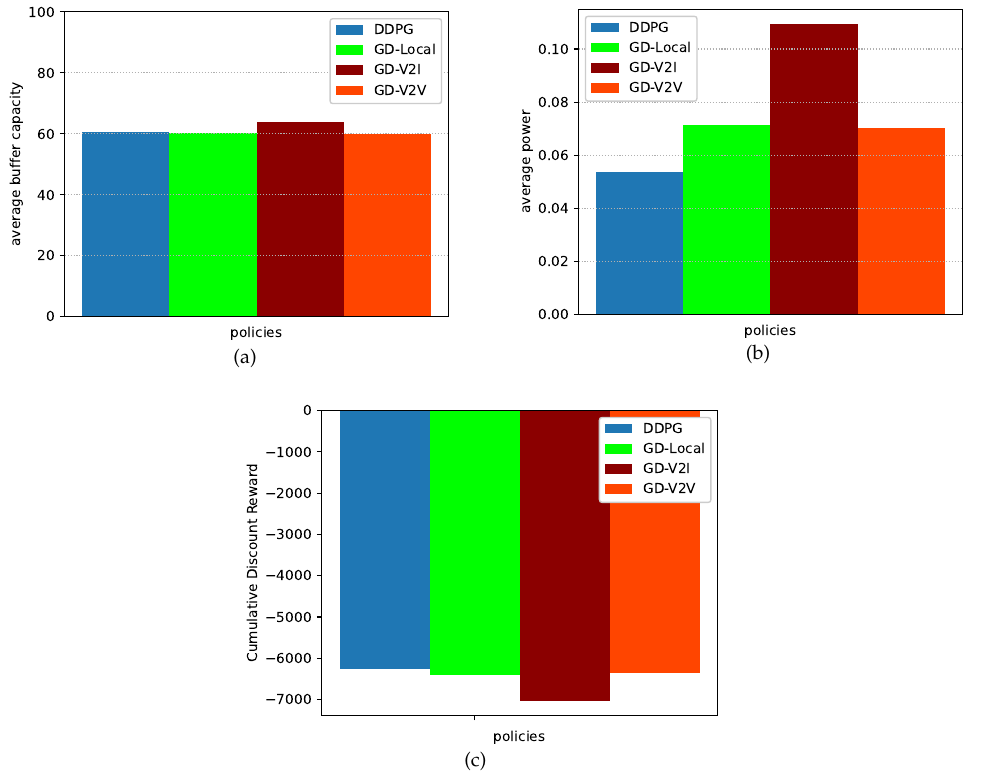
Figure 6. Performance. ( a ) Average buffer capacity. ( b ) Average power consumption. ( c ) Cumulative discount